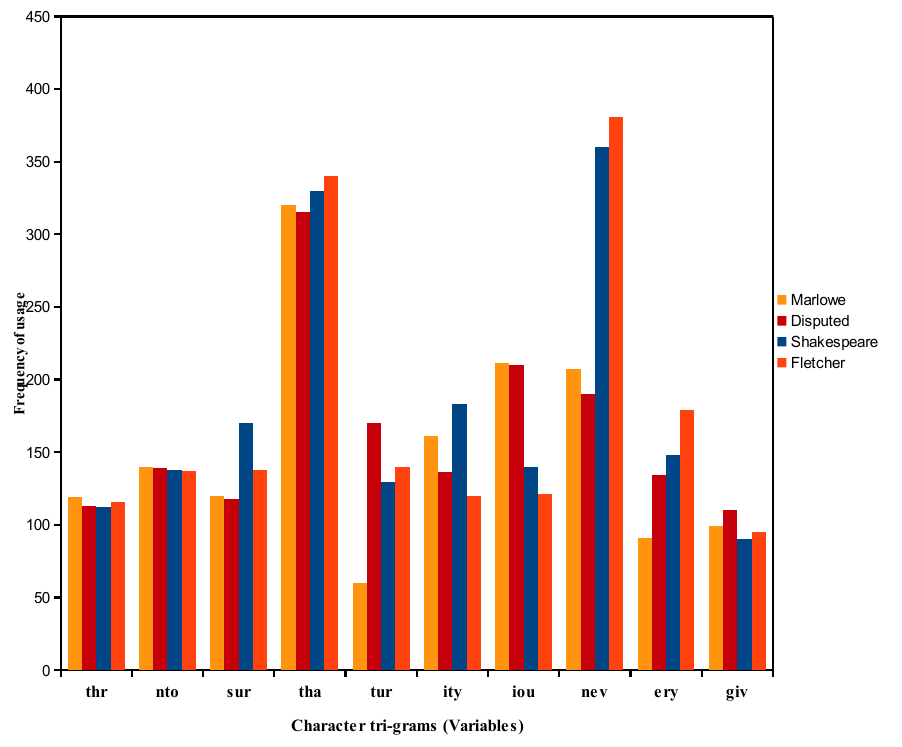
Figure 30. Characters tri-gram centroid-based bar plot for Shakespeare, Marlowe, Fletcher, and the disputed